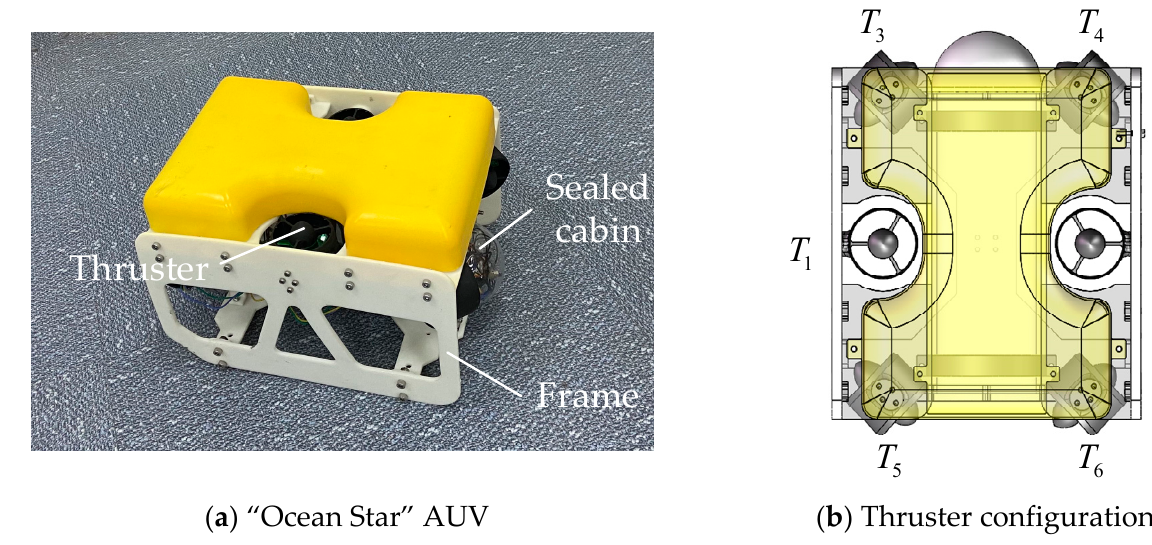
Figure 7. The mechanical structure and physical drawing.